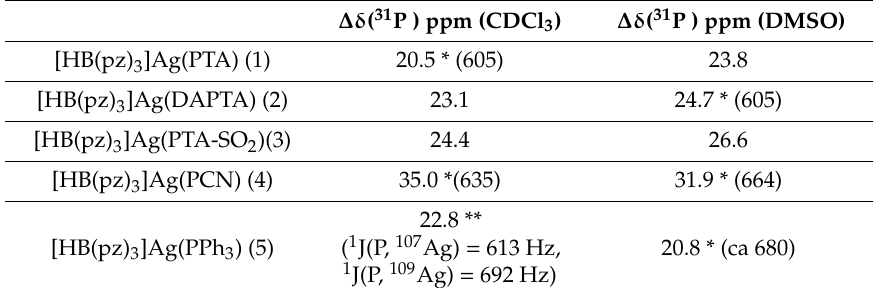
Table 1. 31 P NMR parameters. ∆ δ ( 31 P )(ppm) = δ ( 31 P complex ) − δ ( 31 P ligand ) (ppm) * doublet, ** doublet of doublets. In brackets 1 J(Ag-P) in